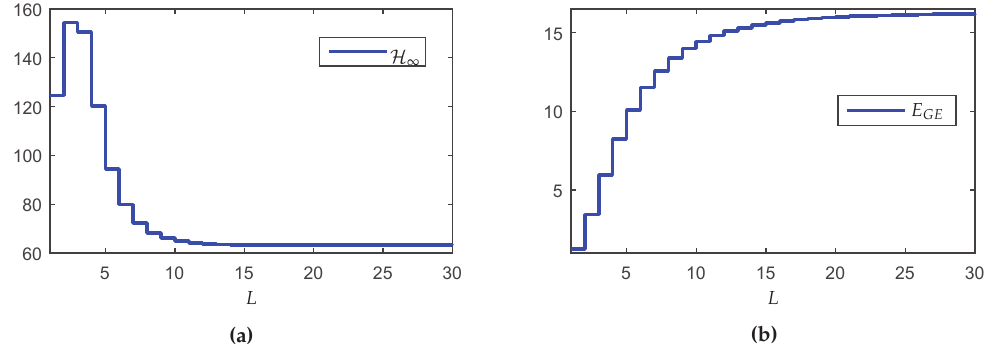
norm of the closed-loop system ( b ) Expected number of global transmissions by Figure 6. ( a ) H ∞ ( M ) ) ( c ) Global energy consumption of the network ( E GE ) computed for each setting ξ of the route ( E network associated with the exchange sequence I Lm